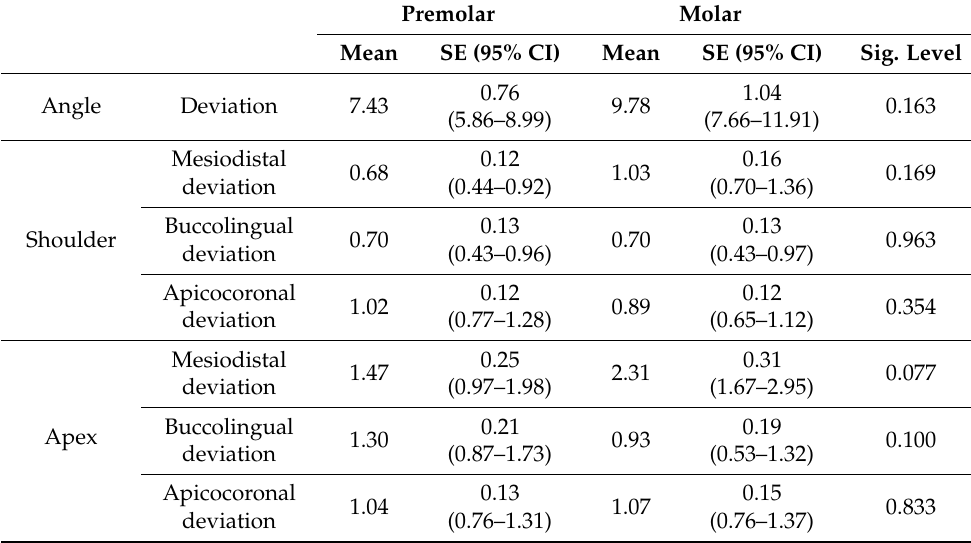
Table 5. Deviations between the planned and achieved implant position depending on the tooth region. Premolar (N = 24) Molar (N = 28). Angle variance ( ◦ ). Linear deviation (mm). Kruskal–Wallis test with a significance level of p <